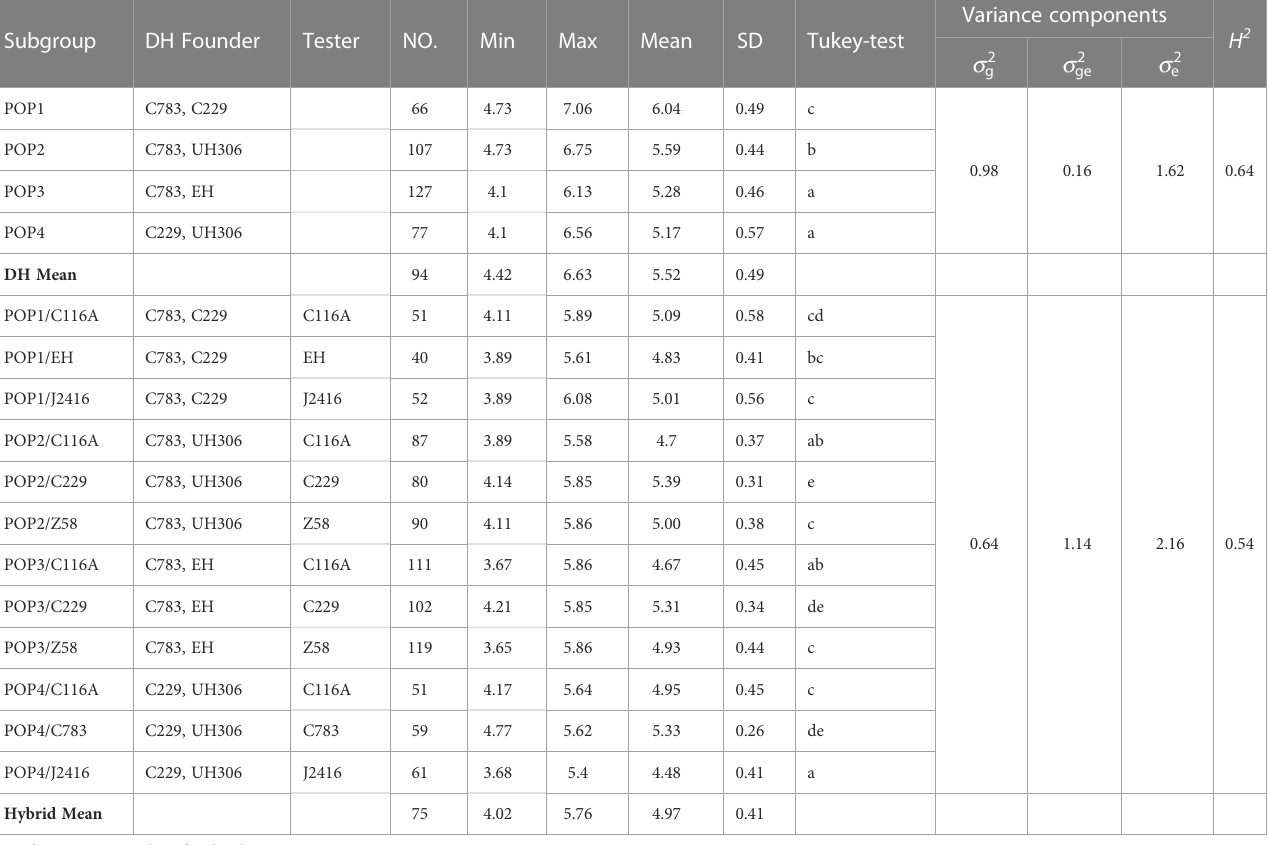
TABLE 2 Descriptive statistics, variance components, and broad-sense heritability ( H 2 ) of southern corn rust resistance.